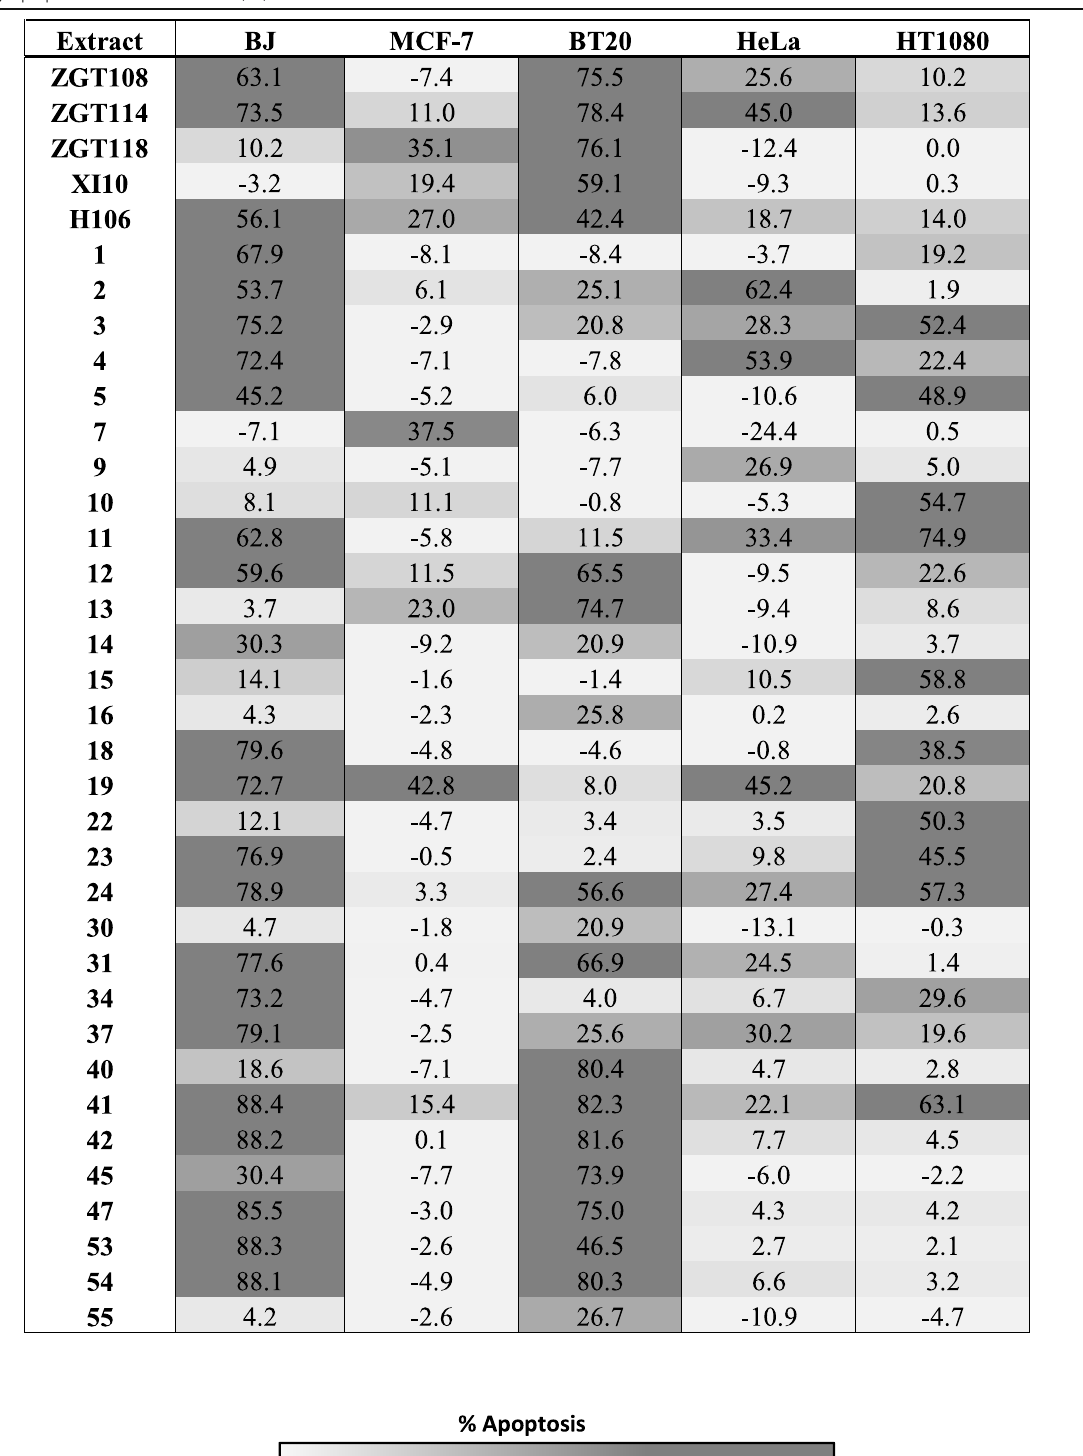
Table 3 The percentage apoptotic cell death induced by selected extracts in various cell lines. Heat map of extracts (200 μ g/ml) inducing apoptosis in one normal (BJ) and selected cancer cell lines after 48 h